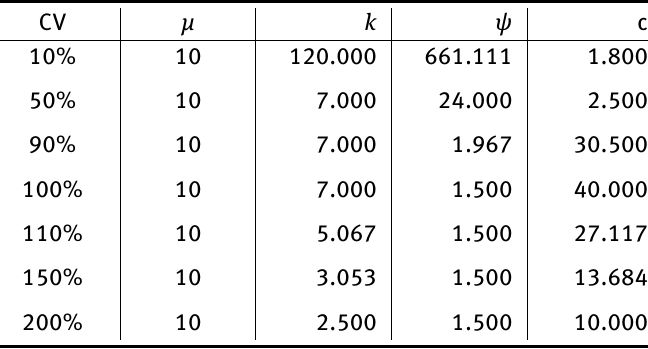
Table 1: Combinations of parameters for the GB2 posterior means